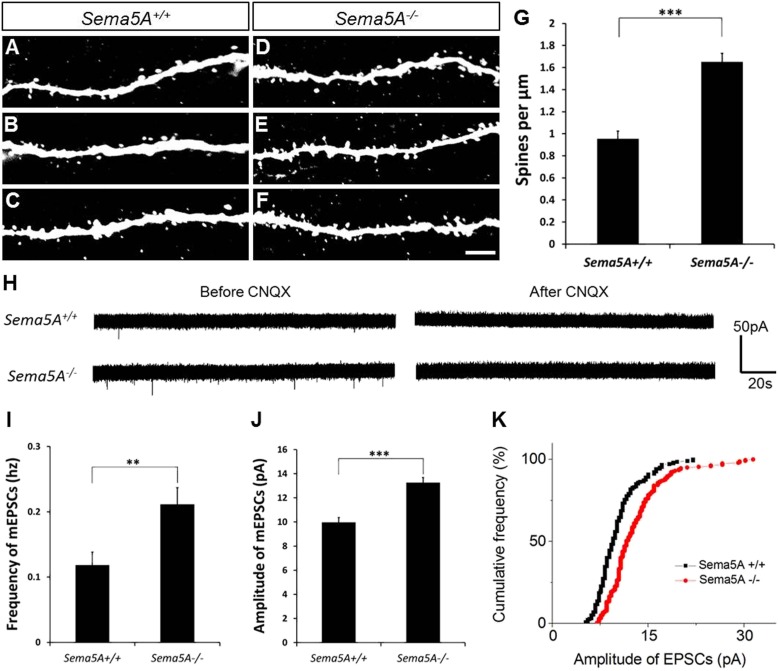
In adult-born GCs, Sema5A negatively regulates dendritic spine density and affects their electrophysiological properties.(A–F) Representative images of dendritic segments of adult-born, 19- to 21-day-old retrovirally-labeled GCs in 3-month-old Sema5A+/+ and Sema5A−/− mice. (G) Quantification of dendritic spine density in adult-born GCs of Sema5A−/− (n = 34 neurons) and Sema5A+/+ (n = 35 neurons) mice. Error bars represent ± SEM, n = 3 independent animals per genotype. ***indicates p < 0.0001, two-tailed unpaired Student's t test. Scale bar = 5 µm. (H–K) Recordings of spontaneous mEPSCs from retrovirally-labeled adult-born GCs at 19–21 days postmitosis. (H) Shown are sample voltage-clamp whole-cell recording traces (Vm = −65 mV) from Sema5A+/+ (top) and Sema5A−/− (bottom) animals before and after bath application of CNQX (20 μM). (I) Quantification of AMPA-type mEPSC mean frequency and (J) mean amplitude. (K) Relative cumulative frequency distribution of mEPSC amplitudes in Sema5A+/+ (black) and Sema5A−/− (red) GCs. The distribution of mEPSC amplitudes in mutants is significantly shifted to the right, indicating an increase in the proportion of larger amplitude events. Recordings were performed in the presence of TTX (1 μM) and bicuculline (10 μM). Values are represented as mean ± SEM. Sema5A+/+, n = 13 cells/6 mice and Sema5A−/−, n = 13 cells/6 mice. **p < 0.01, ***p < 0.001, Student's t test.